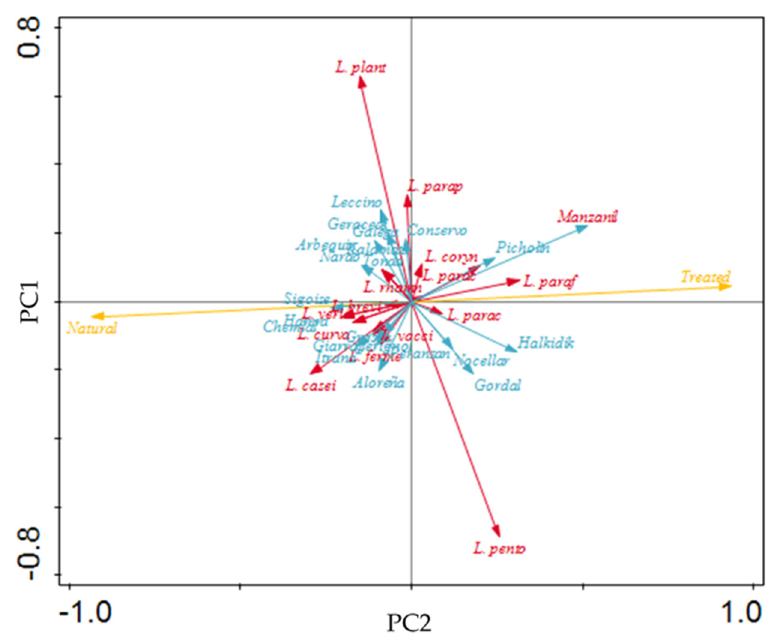
Figure 8. Plot of loadings formed by principle component analysis. LAB, method type, and cultivar are represented in red, yellow, and blue, respectively.